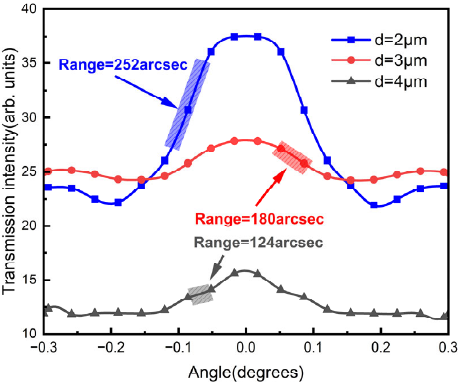
Figure 7. Simulated transmission intensity with different grating periods in which d = 2 µ m, 3 µ m and 4 µ m, respectively.